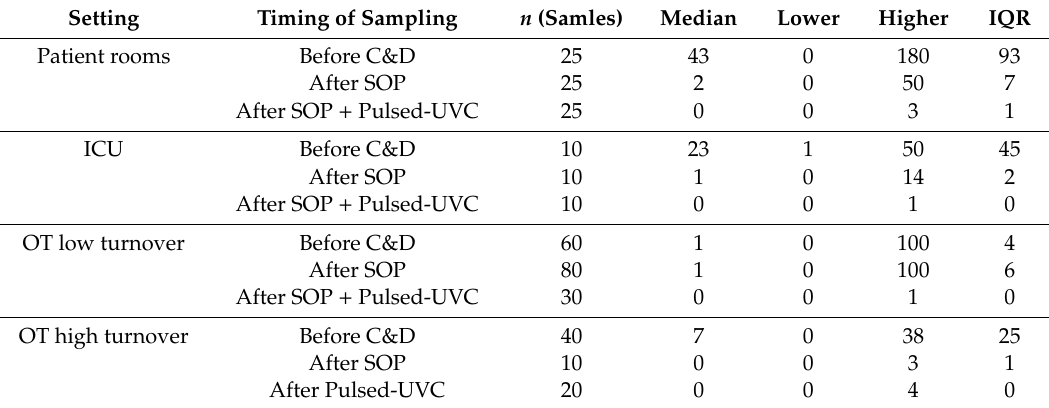
Table 1. Median, lower, and higher values of the bacterial load detected in each hospital setting.